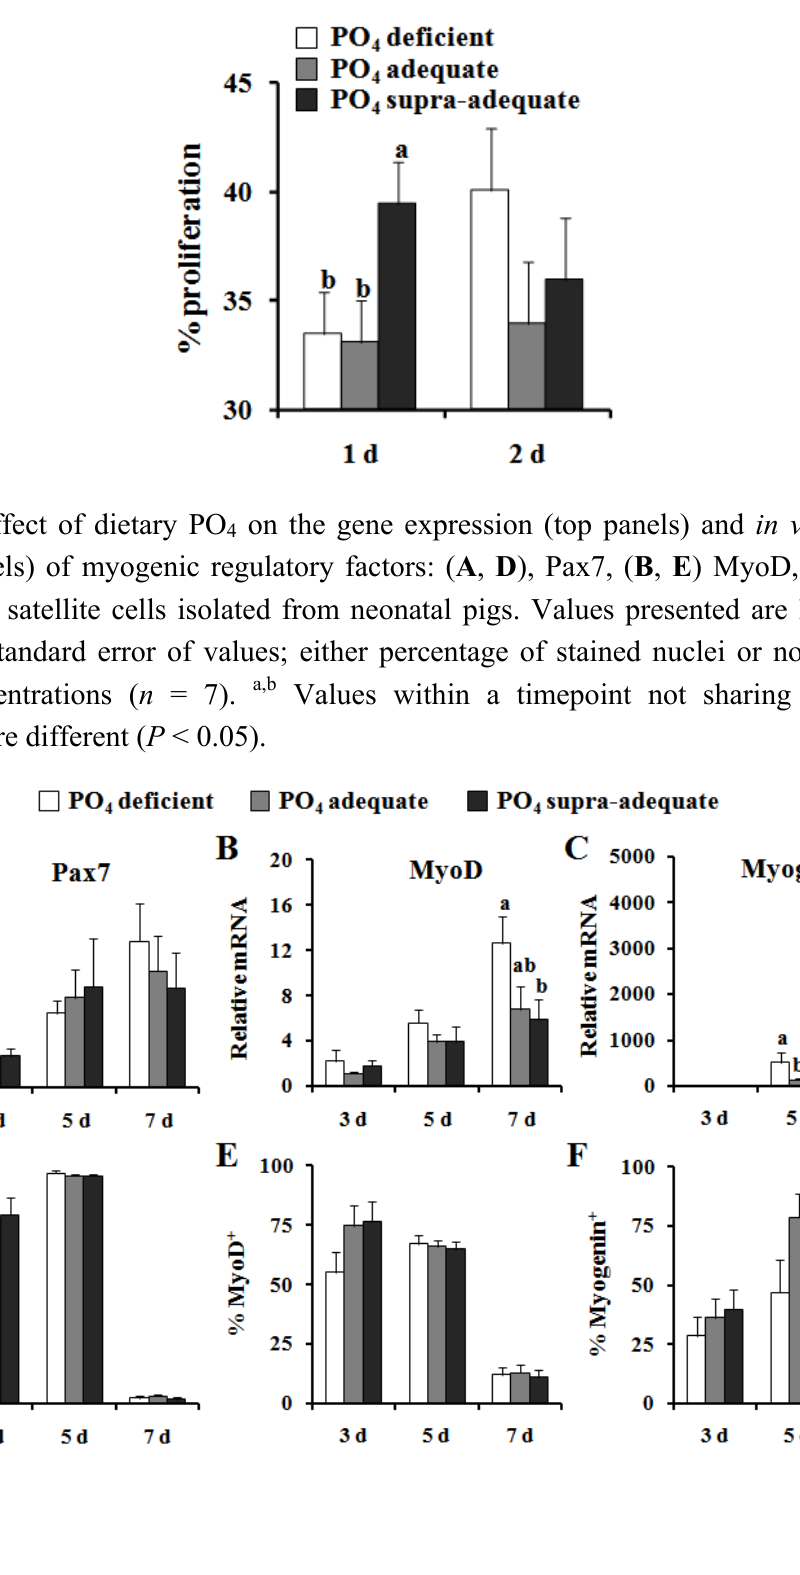
Figure 2. Effect of dietary PO on in vitro satellite cell proliferation. a,b Values not sharing 4 a common superscript are different ( P < 0.05). Values presented are least square means and standard error ( n = 7).